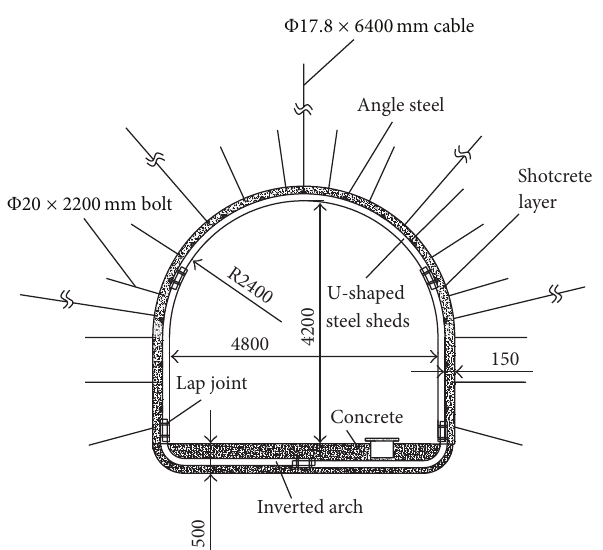
Figure 3: The old supporting design of the roadway.